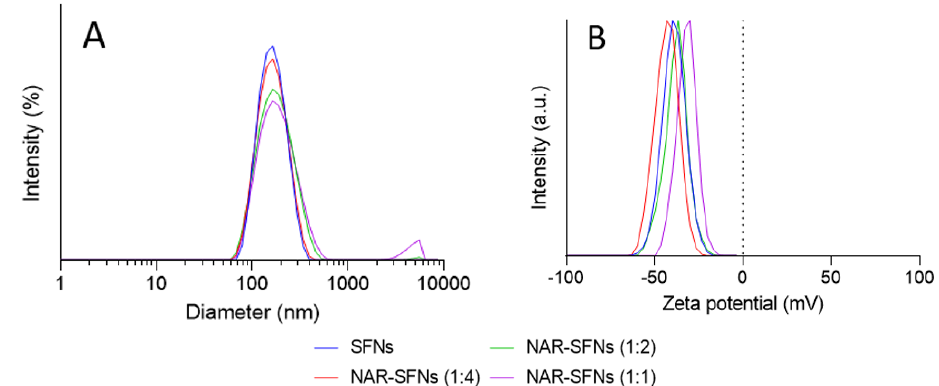
Figure 1. Size distribution ( A ) and zeta potential ( B ) of virgin silk fibroin nanoparticles (SFNs) (blue) and naringenin-loaded silk fibroin nanoparticles (NAR-SFNs) prepared from the three NAR / SFN ratios: 1:4 (red), 1:2 (green) and 1:1 (purple).